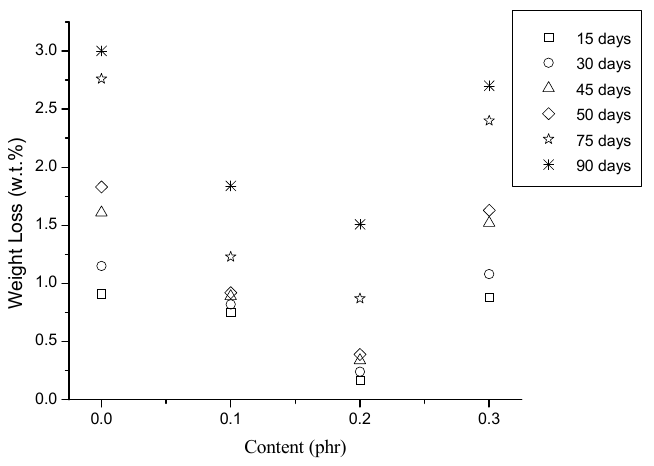
Figure 9. Weight loss of the PLA and PLA/MWCNT-Ag nanocomposites.